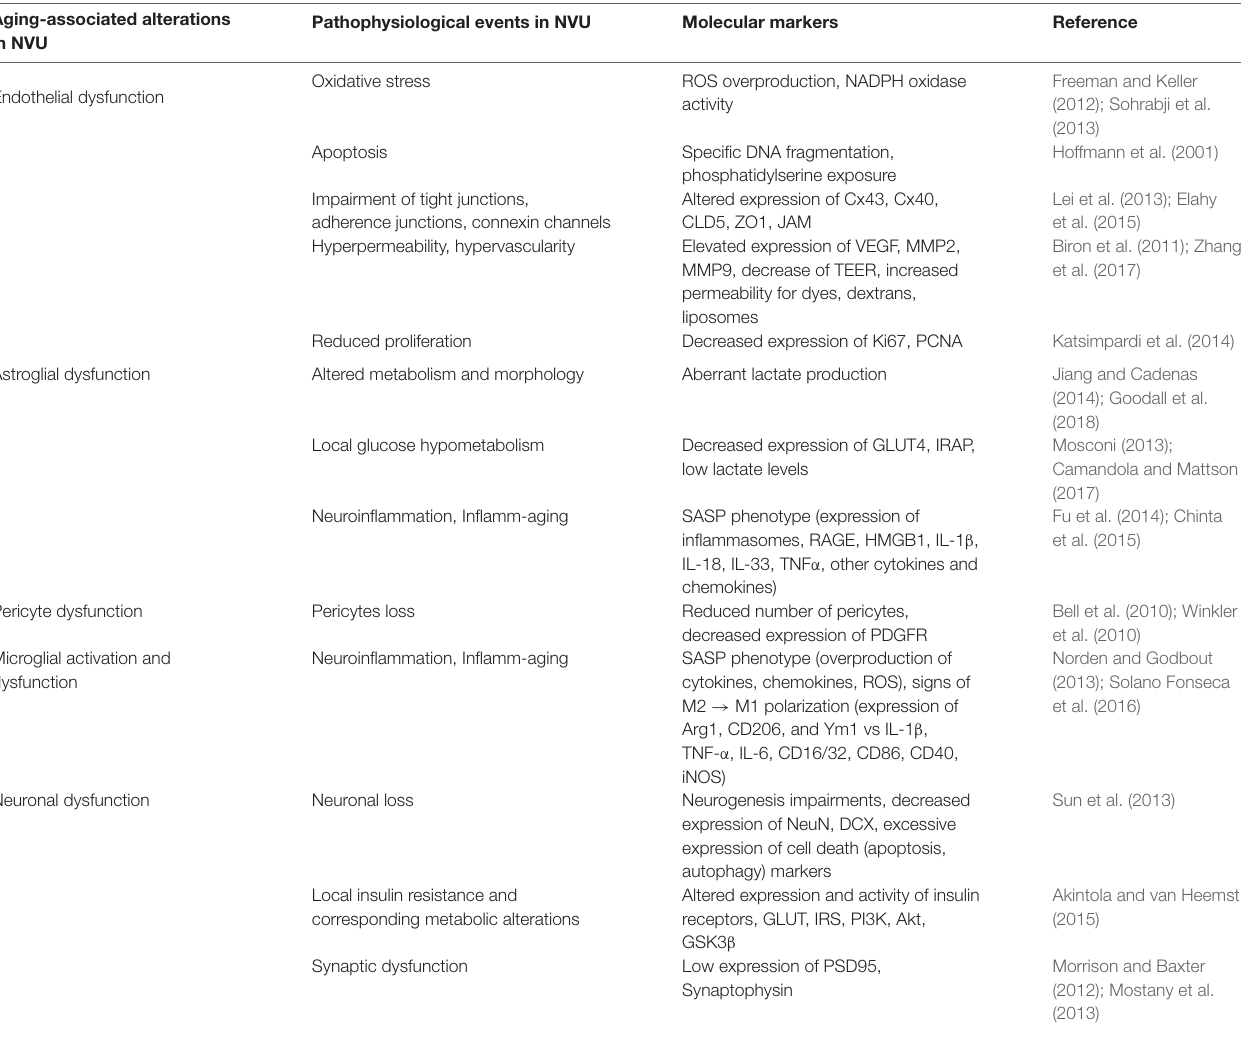
TABLE 1 | Main molecular mechanisms and markers of aging-associated alterations in neurovascular unit (NVU). Aging-associated alterations in